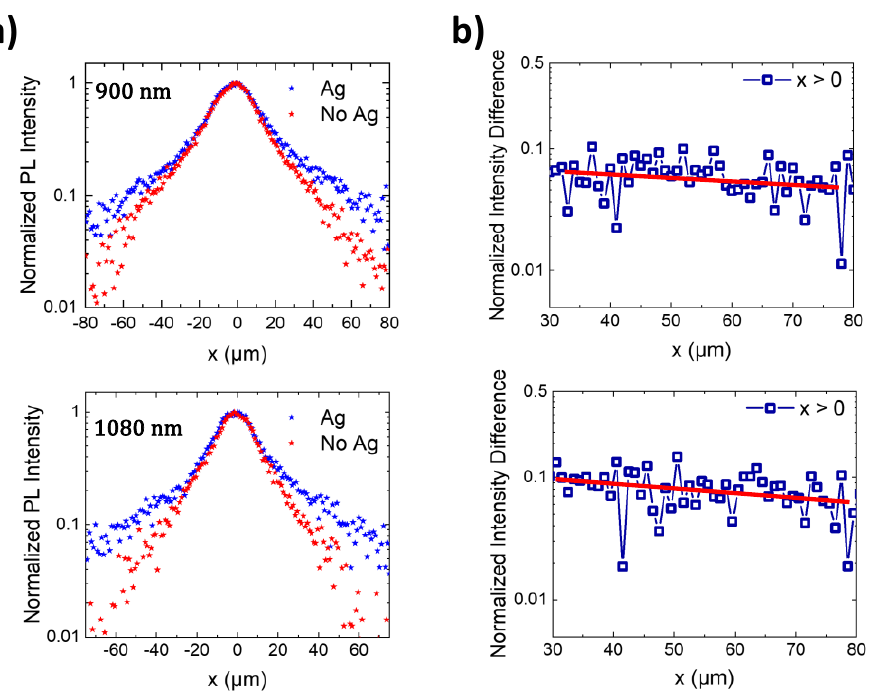
Figure 3. ( a ) Normalized PL intensity profiles associated with the 4 F 3/2 → 4 I 9/2 (top) and 4 F 3/2 → 4 I 11/2 (bottom) electronic transitions of Nd 3+ ions. The excitation is focused at x = 0 μm. ( b ) Difference between the normalized PL intensity profiles shown in panel ( a ) obtained at spatial distances far away from the excitation beam (x > 30 μm). Solid red lines are guides for the eye.